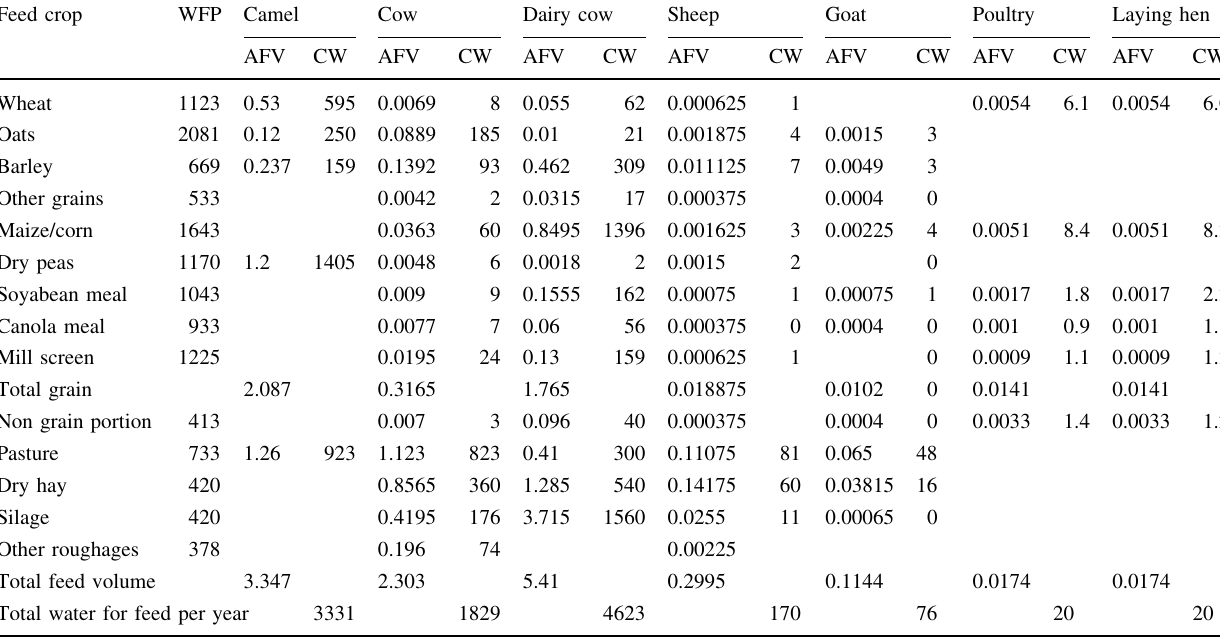
Table 3 Indicative calculations of VWC for feed of a farm livestock animal in Riyadh (after: Chapagain and Hoekstra 2003; Mekonnen and Hoekstra 2012; Abdallah and Faye 2013; Abbas 2013; field survey) Feed crop WFP Camel Cow Dairy cow Sheep Goat Poultry Laying hen